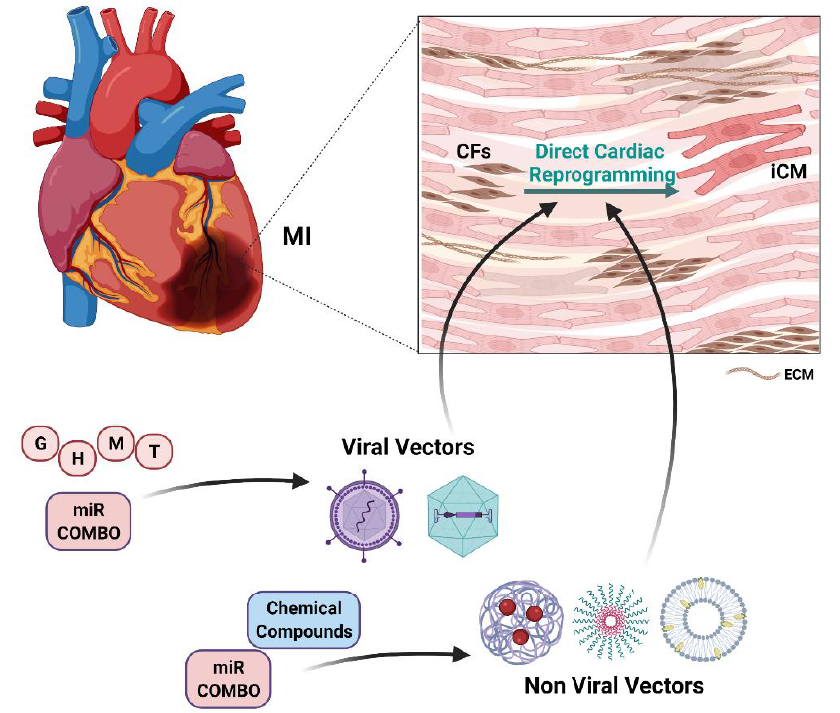
Figure 3. Strategies for in vivo direct cardiac reprogramming. Myocardial Infarction (MI); Cardiac Fibroblasts (CFs); induced Cardiomyocytes (iCMs); Extracellular Matrix (ECM); miR-1, miR-208, miR-133, miR499 (miR Combo); Gata4 (G); Hand2 (H); Mef2c (M); Tbx5 (T). Solid arrows indicate direct involvement. The figure is created with BioRender.